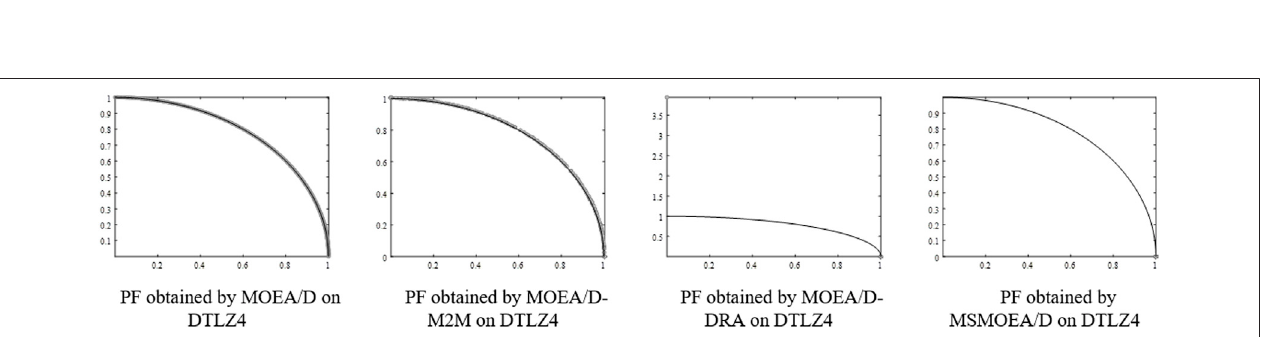
Frontiers in Energy Research |